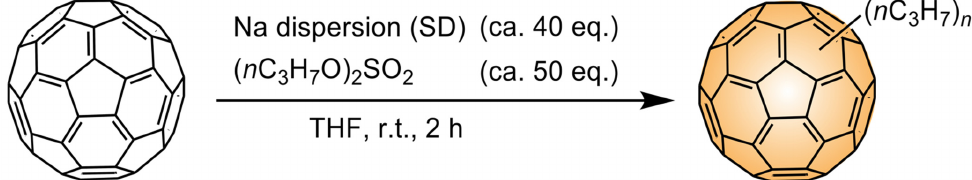
Scheme 1. Reaction of C 60 with SD in the presence of DS.